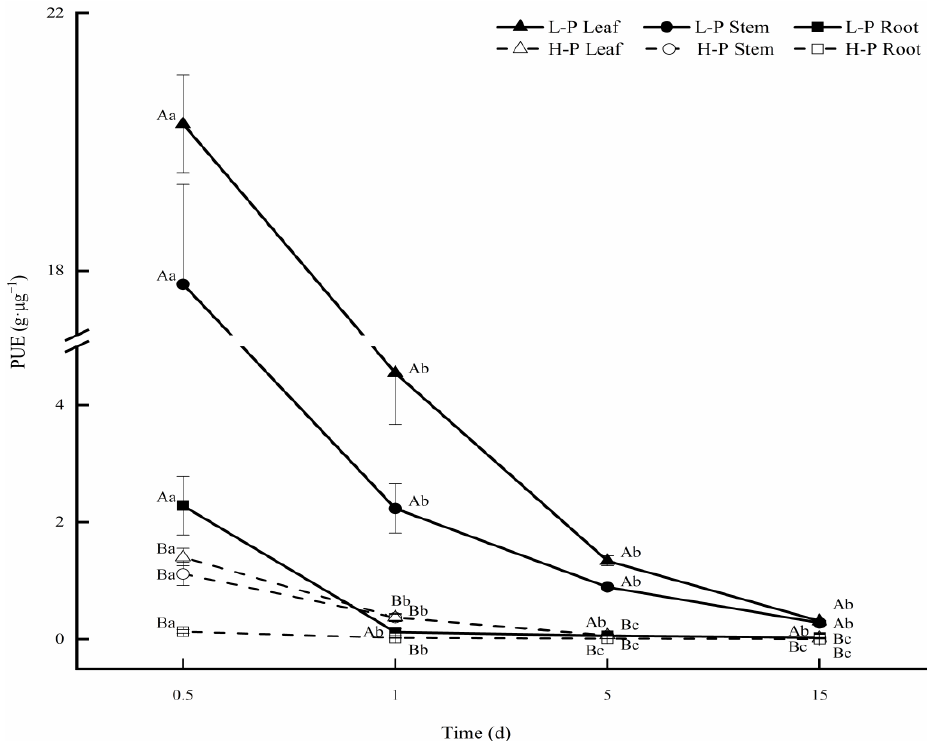
Figure 7. PUE in different organs under high- and low-P treatments. “L-P” and “H-P” represent the low-P and high-P treatments, respectively. Error bars represent standard errors, and each point in the figures represents the mean of the five replicates ( n = 5). Lowercase letters indicate significant differences ( p < 0.05) at different treatment times under the same P treatment. Uppercase letters indicate significant differences ( p < 0.05) between different treatments at each time point.